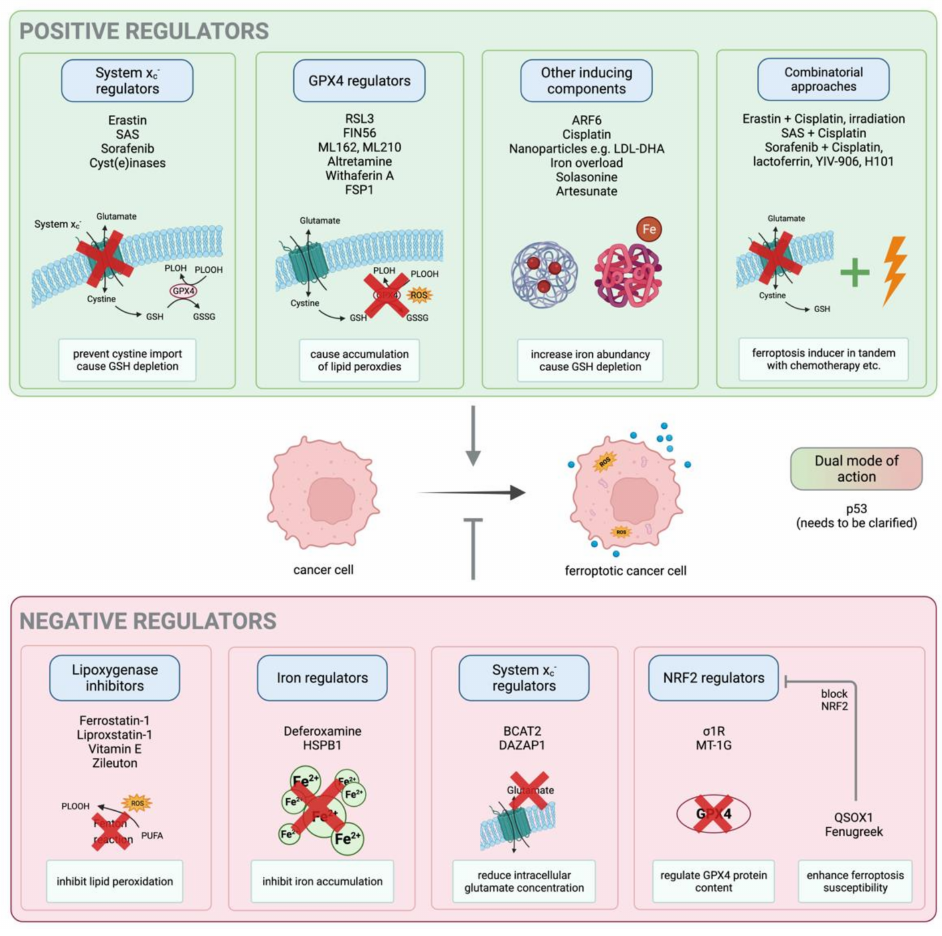
Figure 3. Ferroptosis regulators with known potential relevance to cancer therapy. The initiation and execution of ferroptosis is a highly regulated process. Ferroptosis is activated by several classes of ferroptosis inducers including system x c − inhibitors, GPX4 inhibitors, other inducing components, and combinatorial approaches. Ferroptosis is also inhibited by several pharmacological and genetic agents that inhibit lipid metabolism, lipid peroxidation, and iron metabolism. At the same time,